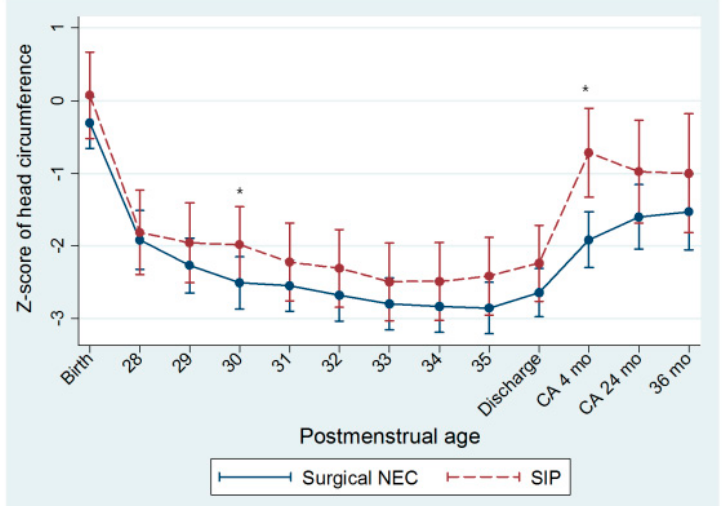
Figure 1. Head growth of preterm infants with surgical necrotizing enterocolitis and spontaneous intestinal perforation. Head growth at 4 months of corrected age was better in preterm infants with SIP. * Indicates p -value < 0.05. CA, corrected age; NEC, necrotizing enterocolitis; SIP, spontaneous intestinal perforation.